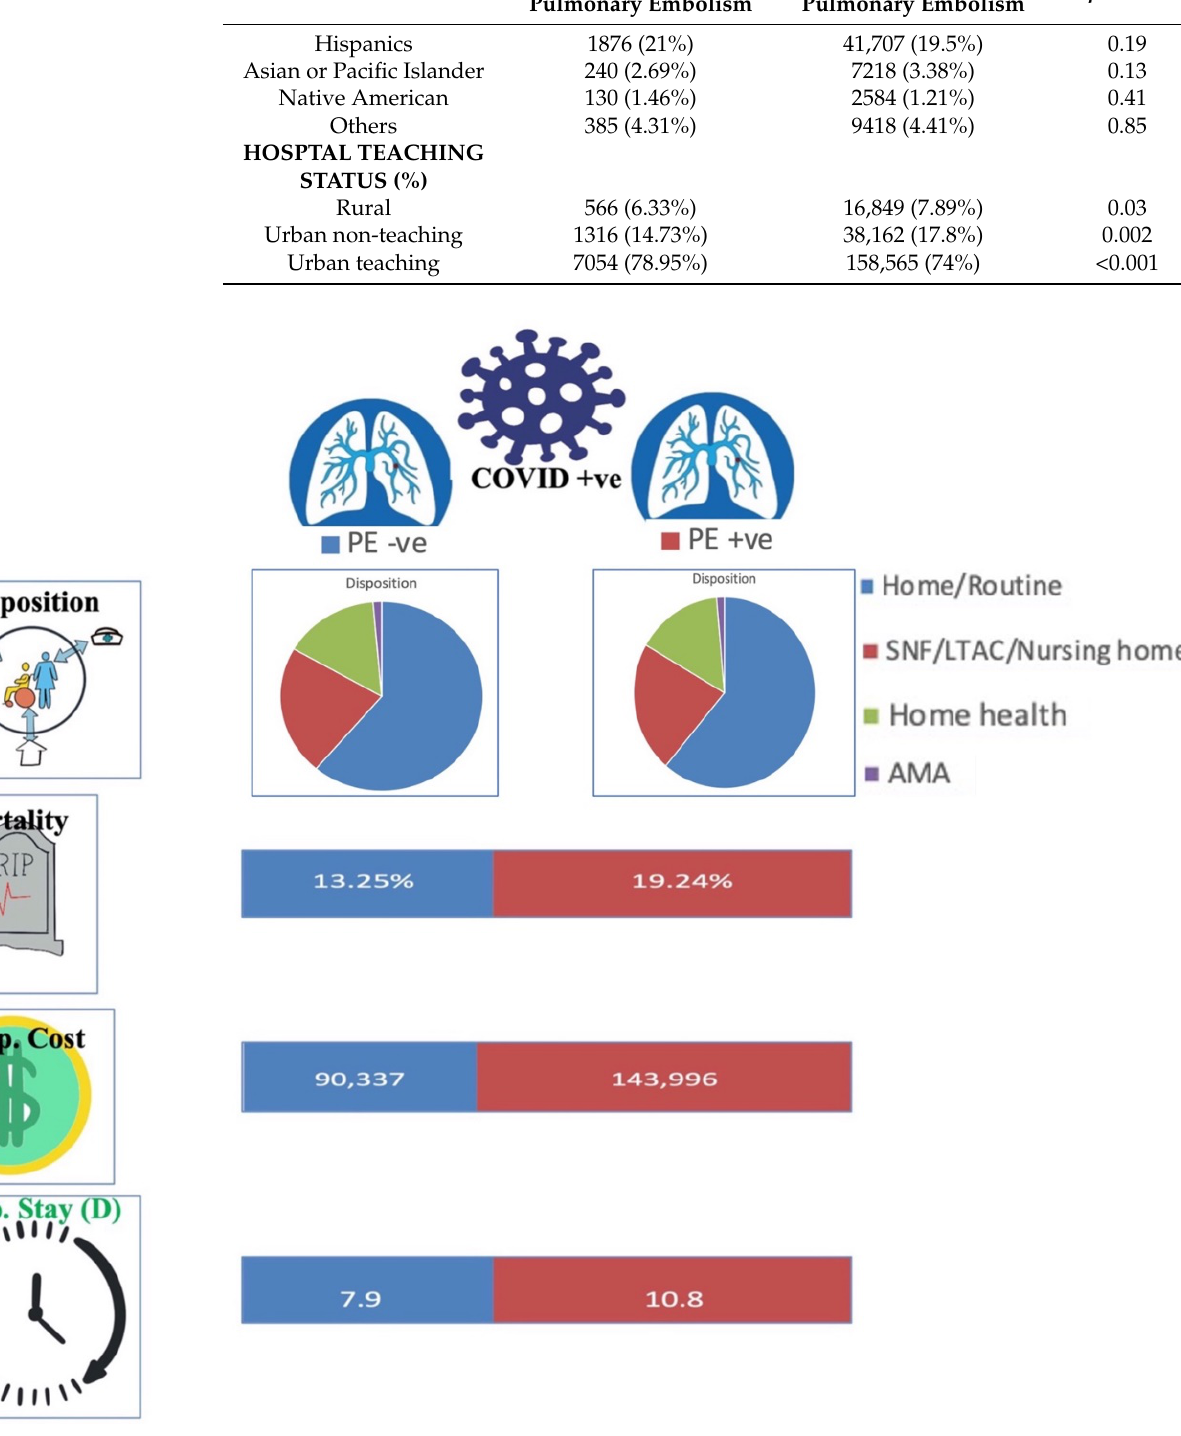
Figure 2. COVID-19 and Pulmonary embolism (PE) patient outcomes. SNF = skilled nursing facility, ALTAC = A long-term acute care, AMA = against medical advice, Hosp. = Hospital, D = days. +ve = Positive, − ve = Negative.